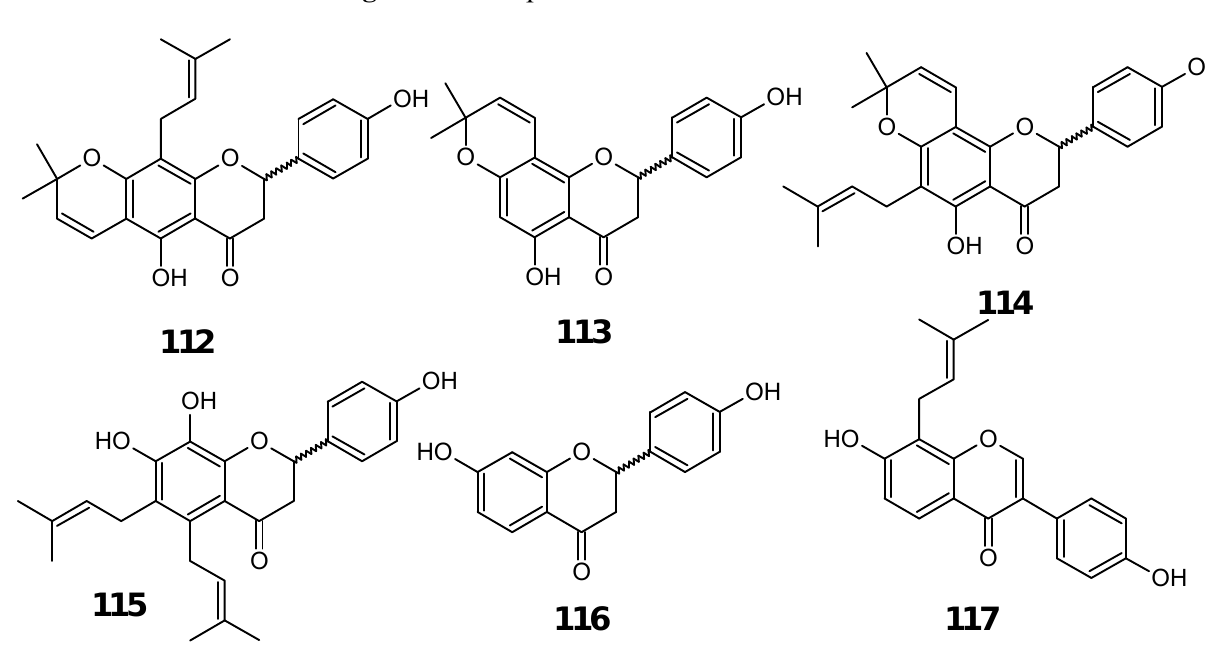
Figure 12. Antiplasmodial flavonoids 112-117